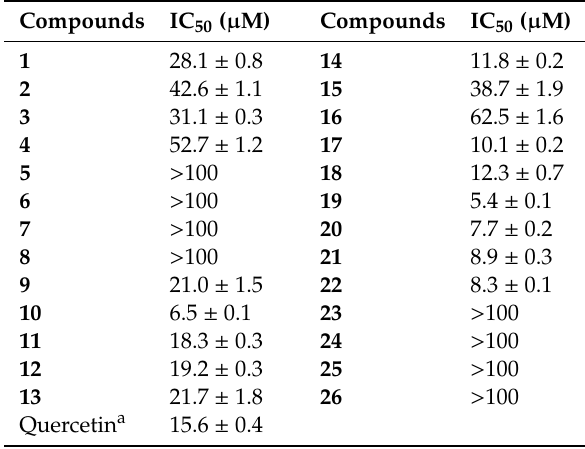
Table 2. NO inhibitory e ff ects of isolated compounds 1 –